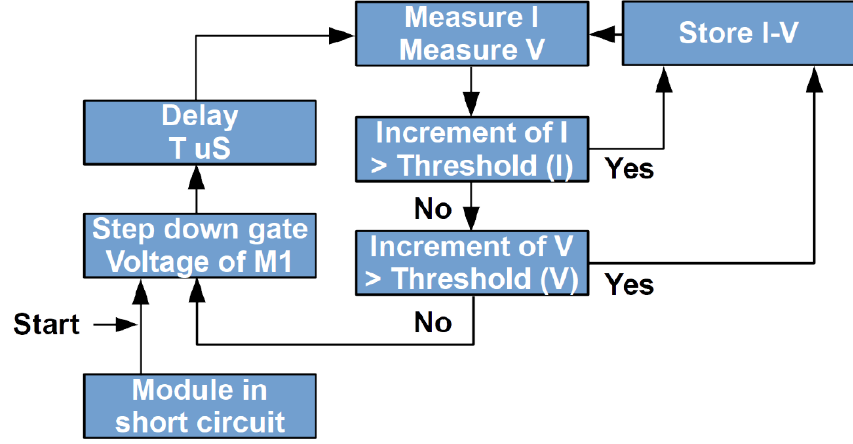
Figure 4. Flow chart showing the basic sweeping control algorithm.